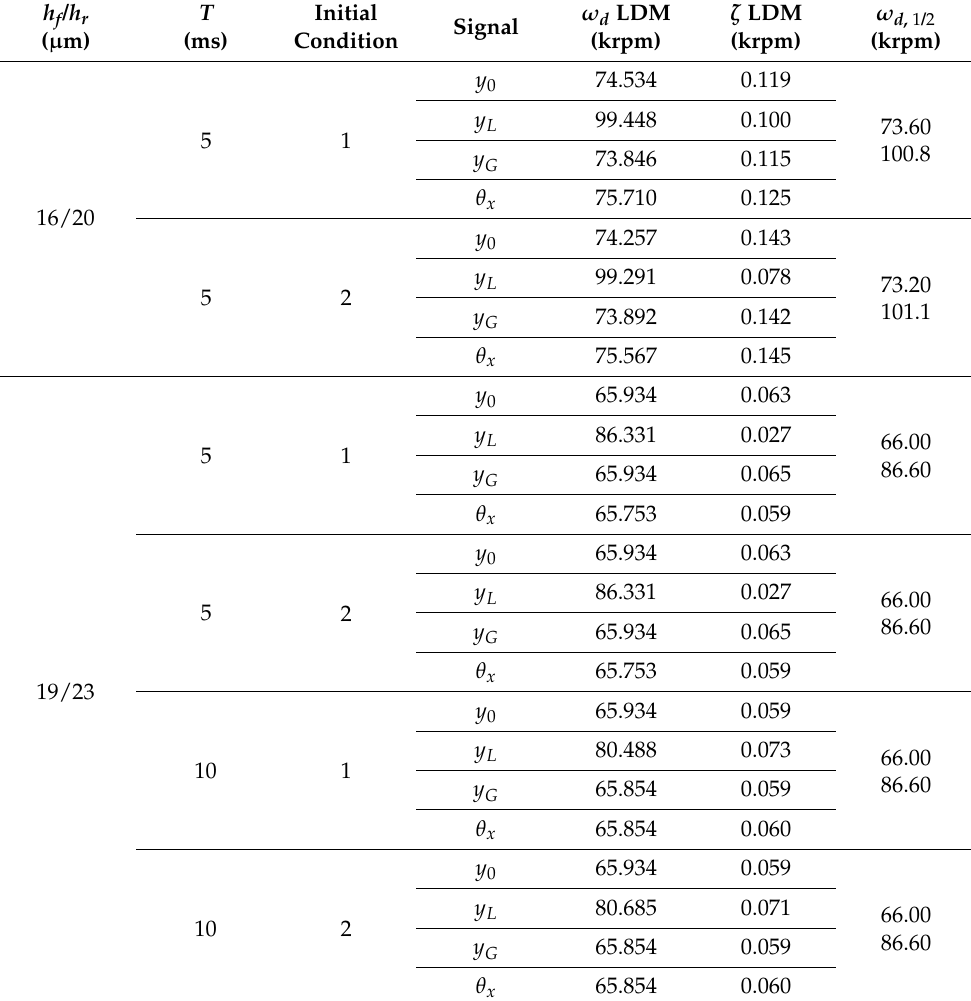
Table A2. Damped frequencies and damping factors resulting from FFT analysis and from LDM; p s = 0.5 MPa.